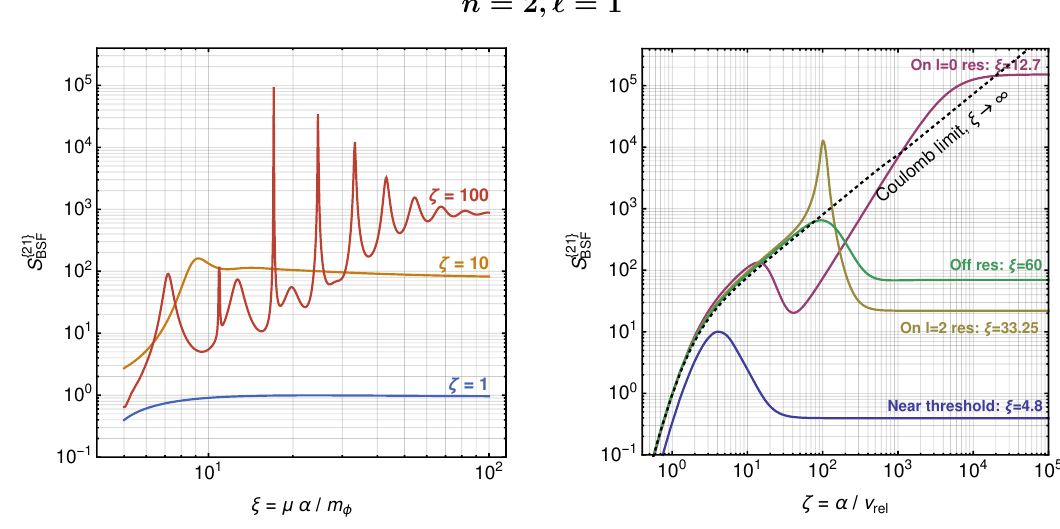
Figure 6 . Resonance structure and velocity dependence of the S f 21 g factor of the total cross- BSF section for the radiative capture into any n = 2 ; ‘ = 1 state, with emission of a vector force mediator [cf. eqs. (3.13)]. Left: S f 21 g receives contributions from the ‘ = 0 and the ‘ = 2 modes BSF of the scattering state wavefunction. The ‘ = 0 mode dominates for small (cid:24) , while the ‘ = 2 mode dominates for larger (cid:24) values (including the Coulomb regime) and gives rise to sharper resonances. Right: at large (cid:16) , the contribution from the ‘ = 2 mode decreases with decreasing velocity as v 4 , rel while the contribution from the ‘ = 0 mode saturates to a constant value and dominates. The superposition of two ‘ modes | which have di(cid:11)erent velocity dependence and resonances | gives rise to the various features of the total